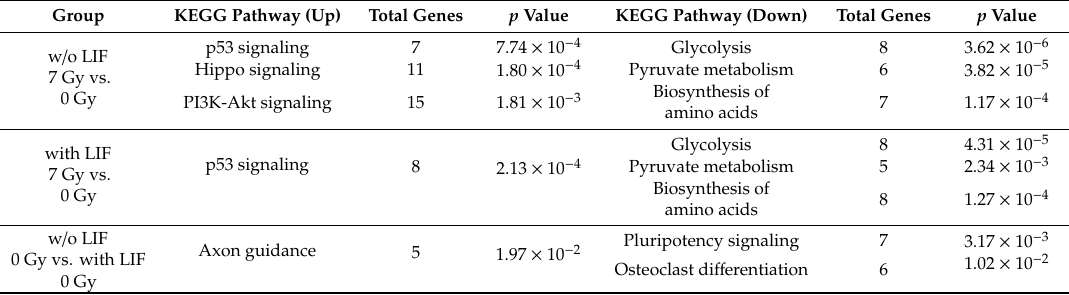
Table 2. Chromosome location of genes with expression that was modified by X-irradiation * or / and LIF in mESCs. Group Gene Regulation Total Genes Chromosome Number w / o LIF 7 Gy vs. 0 Gy Up 32 3 Up with LIF 7 Gy vs. 0 Gy Up w / o LIF 0 Gy vs. with